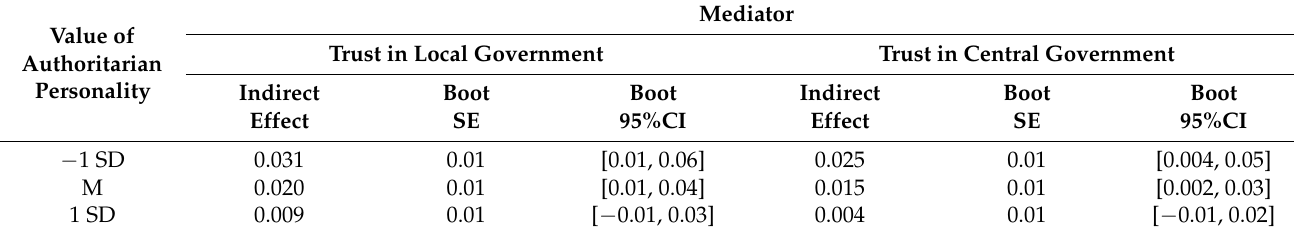
Table 4. Conditional indirect effect as a function of trust in government (N = 933).